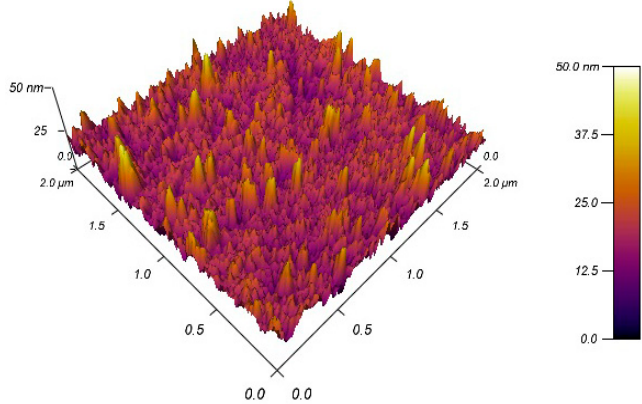
Figure 3. AFM image of PSi